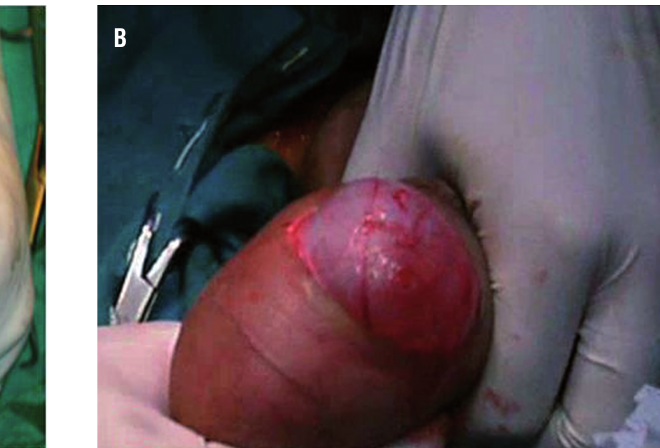
Figure 1A - An operative photograph showing the length of the scrotal skin incision, 2cm (it appears longer due to stretch of the skin by the assistant).